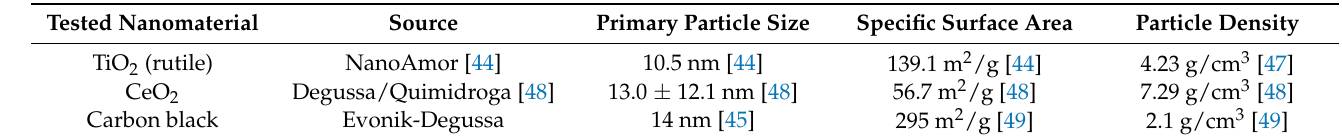
Table 1. Selected physicochemical parameters of the tested